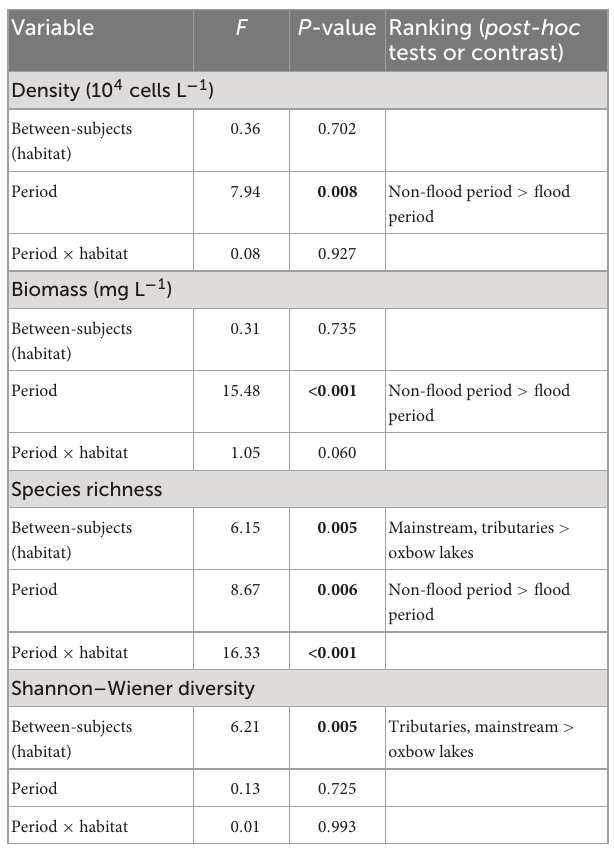
TABLE 2 Repeated-measured ANOVA results of phytoplankton density, biomass, and alpha diversity in different habitats of the White River Basin across two hydrological